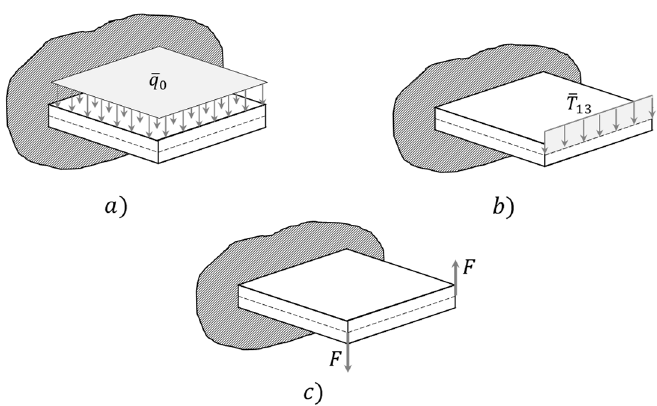
Figure 12. Regular ( a ) and distorted ( b ) 16 × 16 mesh.